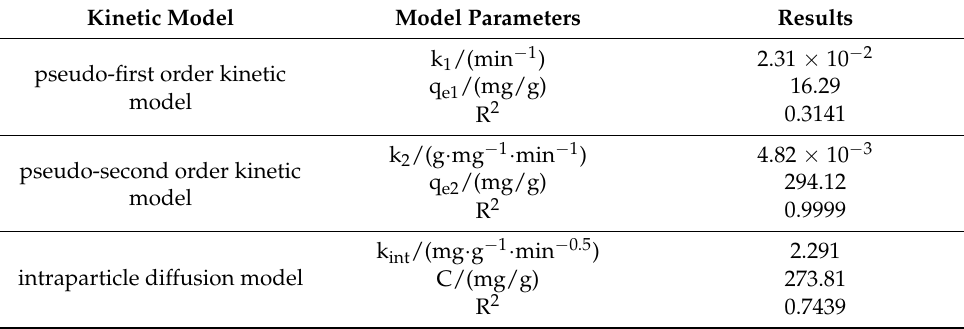
Table 2. Kinetic parameters for Th(IV) adsorbed onto AO-CELL.